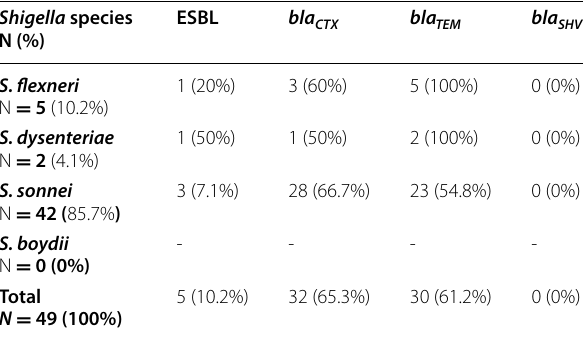
Table 2 The frequency of ESBL encoding genes in Shigella species